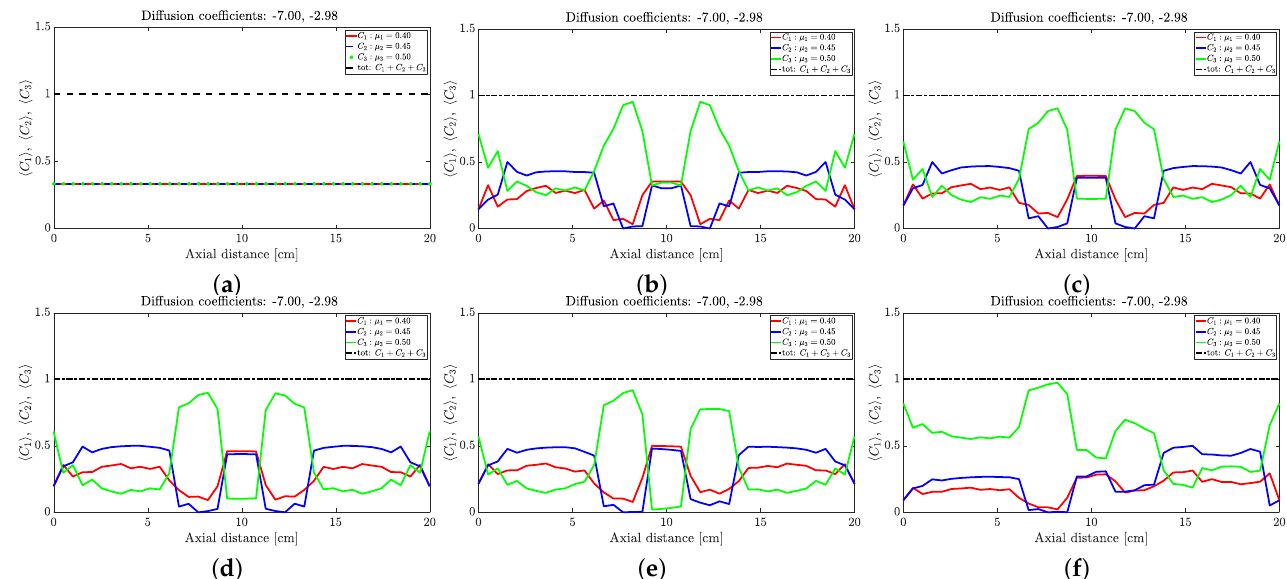
Figure 3. Snapshots of ternary mixture at: ( a ) 0 s ( b ) 20 s, ( c ) 25 s, ( d ) 30 s, ( e ) 32 s and ( f ) 40 s. The corresponding diffusion coefficients are − 7 and − 2.98.